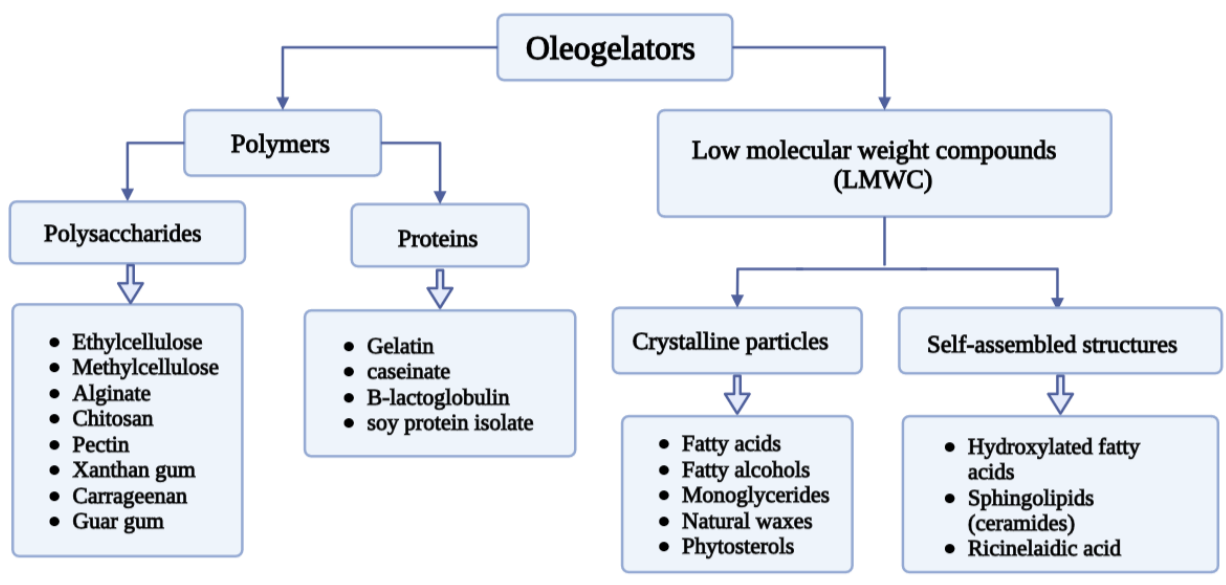
Figure 2. Most widely used edible oleogelators (image created using the BioRender application; https://app.biorender.com).